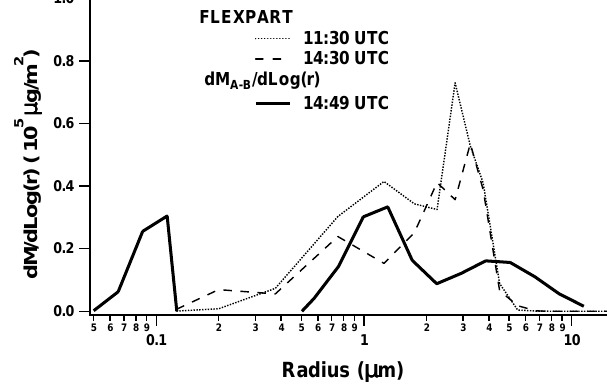
Figure 8 (M. R. Perrone et al.) Fig. 8. Columnar mass size distribution of volcanic particles in-